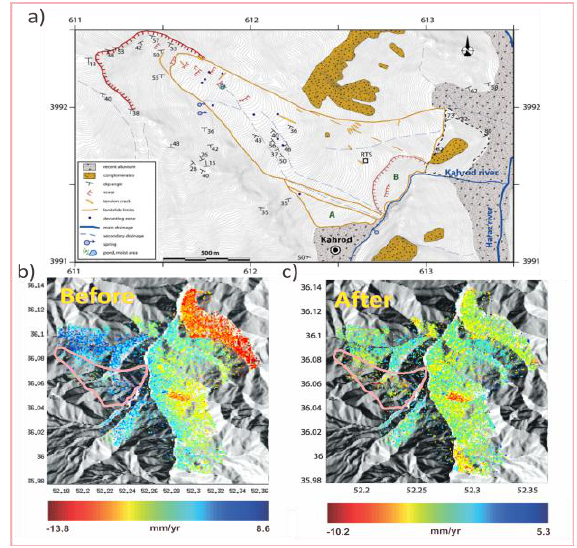
Figure 3: (a) Geomorphologic map of Landslide (Peyret et al., 2008). (b) velocity map calculated by stamps. (c) velocity map calculated by our modified method. Pattern of KAHR (shown